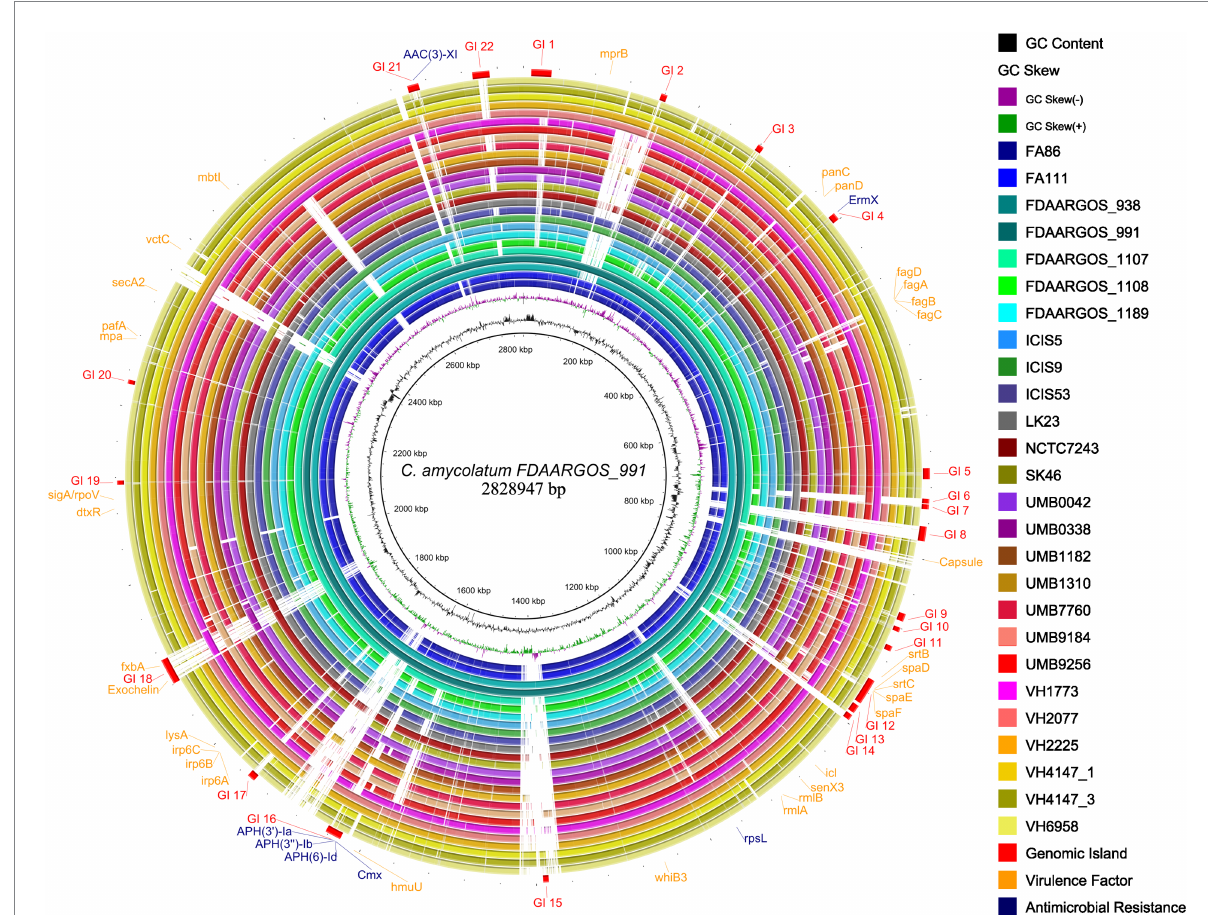
FIGURE 6 Circular genome plot showing the distribution of predicted genomic islands (GIs) in the studied C. amycolatum genomes. Most outer circle presents the positions of GIs and respective AMR genes. The genome sequence of the isolate FDAARGOS_911 was used as a